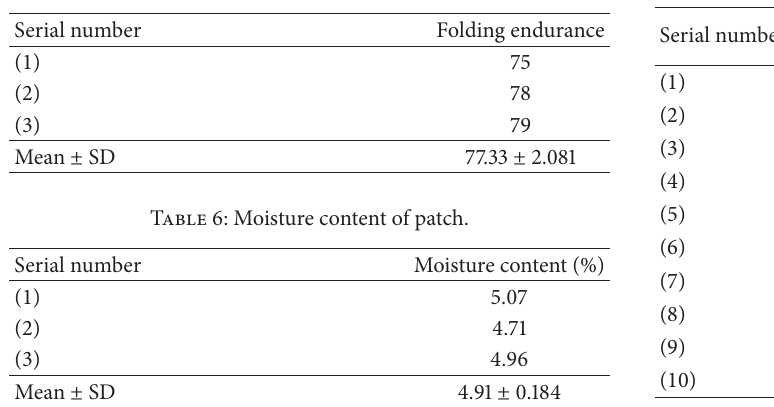
Table 5: Folding endurance of patch.